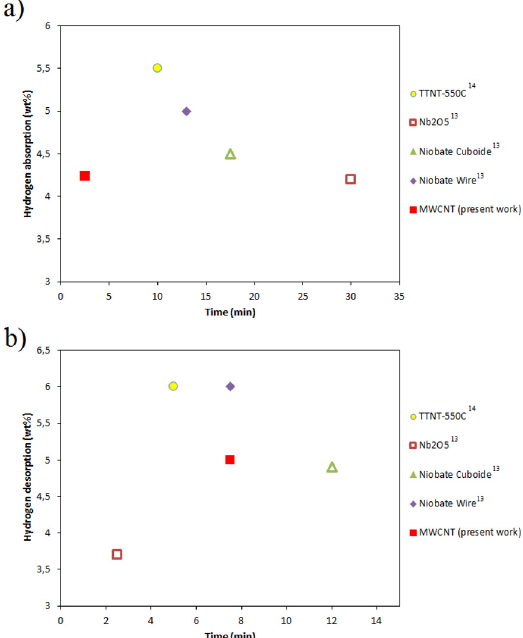
Figure 5. Comparison between the absorption (a) and desorption (b) of hydrogen obtained with 5wt.% of different materials milled with magnesium hydride at 350